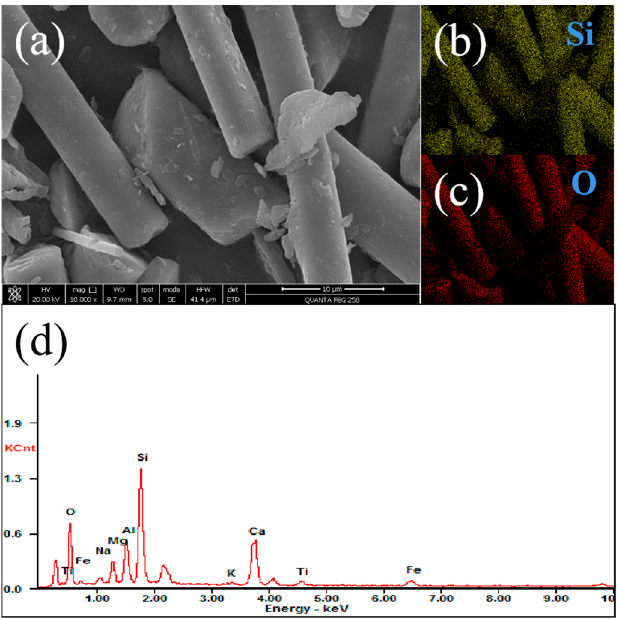
Figure 1. ( a ) SEM image, ( b , c ) elemental mapping, and ( d ) EDS spectrum of basalt rock waste (BRW).